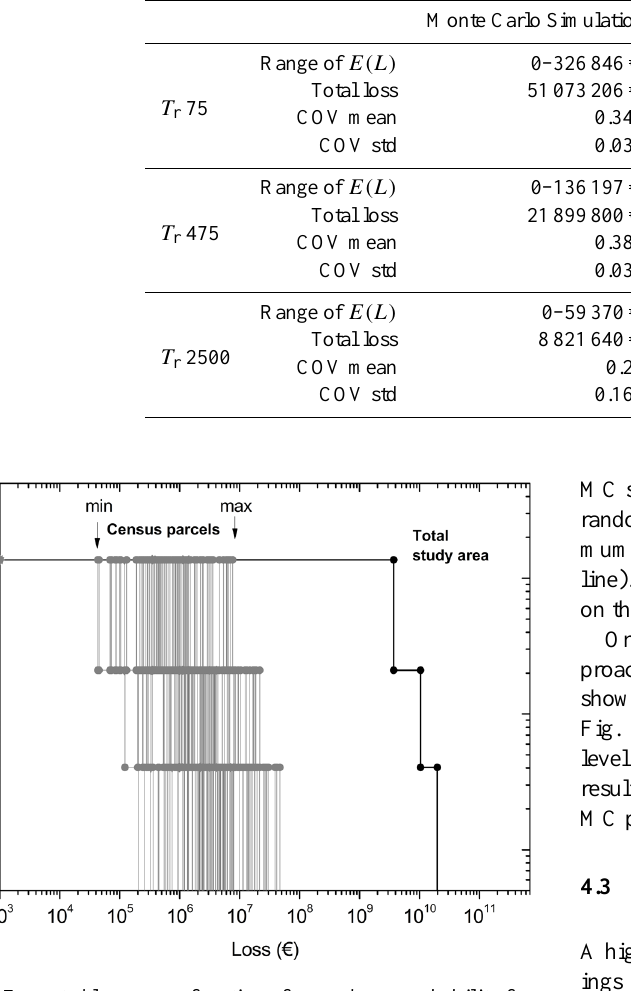
Fig. 10. Expected losses as a function of exceedance probability for seismic risk (Kappos et al., 2006 vulnerability model). Grey curves for a random selection of 100 census parcels, ranging in the grey area between the minimum and the maximum level of risk. Curve for the whole study area is shown in